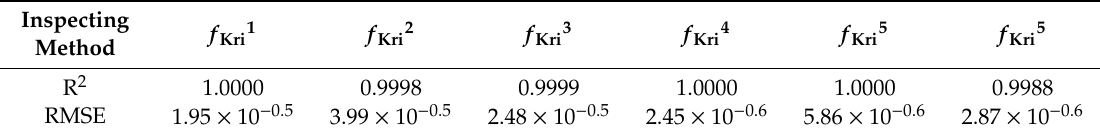
the first six frequencies.